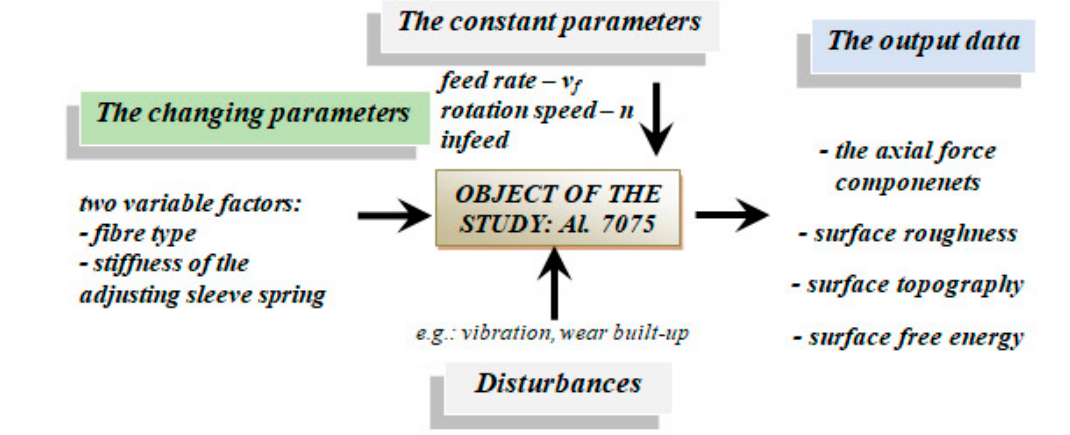
Figure 2. Schematic diagram of the study object.